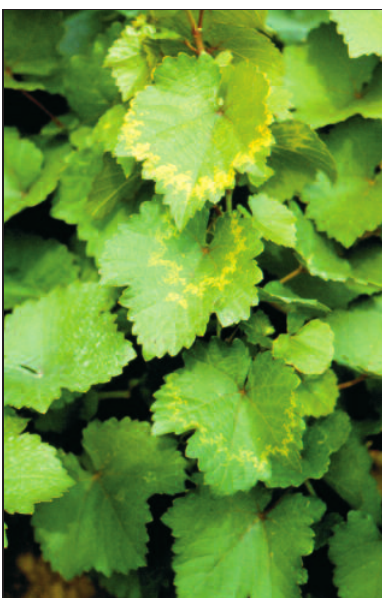
Figure 17. Line pattern (GLPV) – bright yellow discolorations of the leaves in the form of scattered spots of blotches, marginal ring sor maple-leaf line